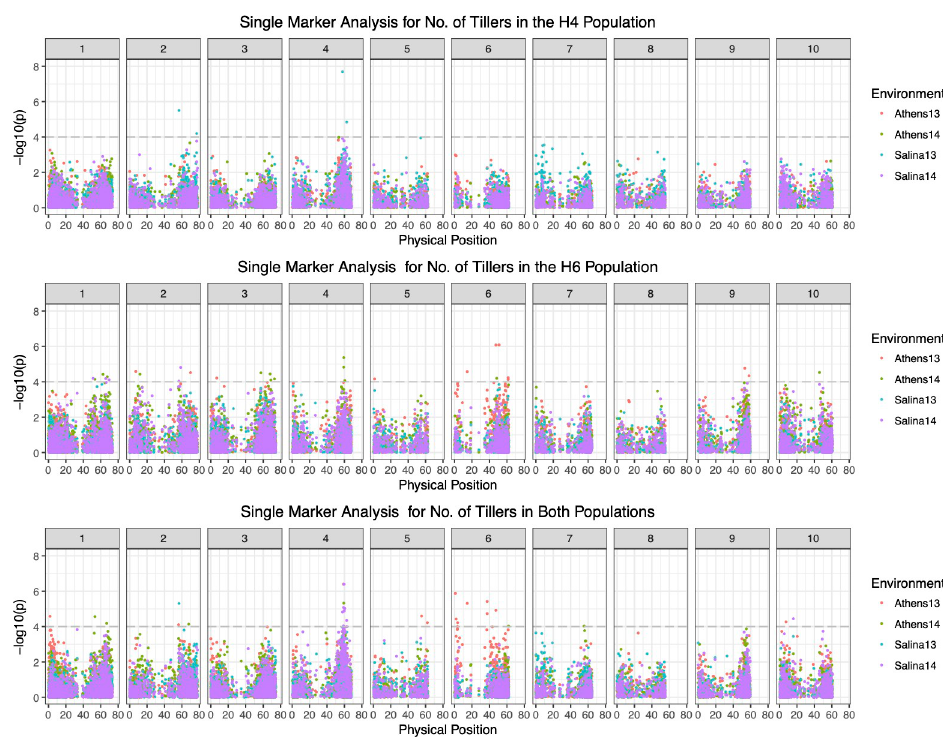
Fig 3. Single marker analysis of the number of mature tillers in the H4, H6 and pooled SBSH BC 1 F 2